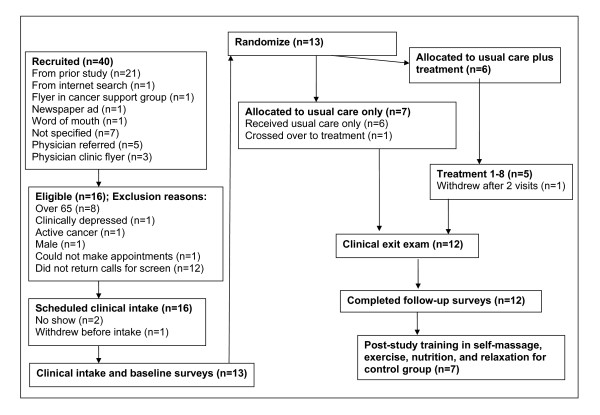
CONSORT diagram.